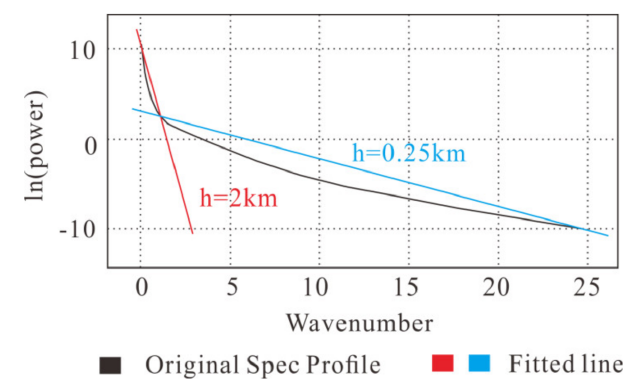
Figure 7. Radial logarithmic power